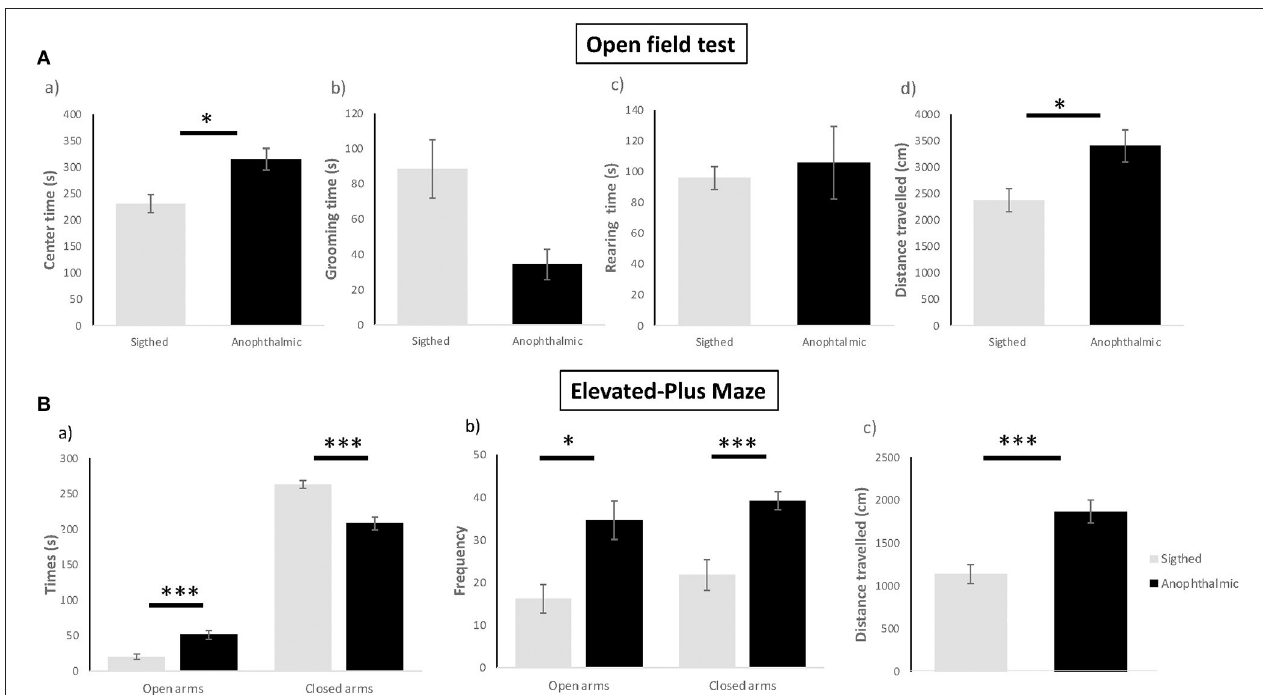
FIGURE 2 | Anxiety-like behavioral tests. Anophthalmic and sighted mice assayed to the open-field test (A) : (a) Mean ( ± SE) time spent (s) of grooming, (b) Latency before the first grooming (s), (c) Frequency of grooming, (d) Distance (cm) traveled in the device for a 5 min-test ( N = 15 and 17 mice/group, respectively). Anophthalmic and sighted mice assayed to the Elevated-Plus Maze (B) : (a) Mean ( ± SE) time spent (s) in open and closed arms, (b) Frequency in open and closed arms, (c) Distance (cm) traveled in the whole device for a 5 min-test ( N = 15 and 17 mice/group, respectively; * p < 0.05; *** p <